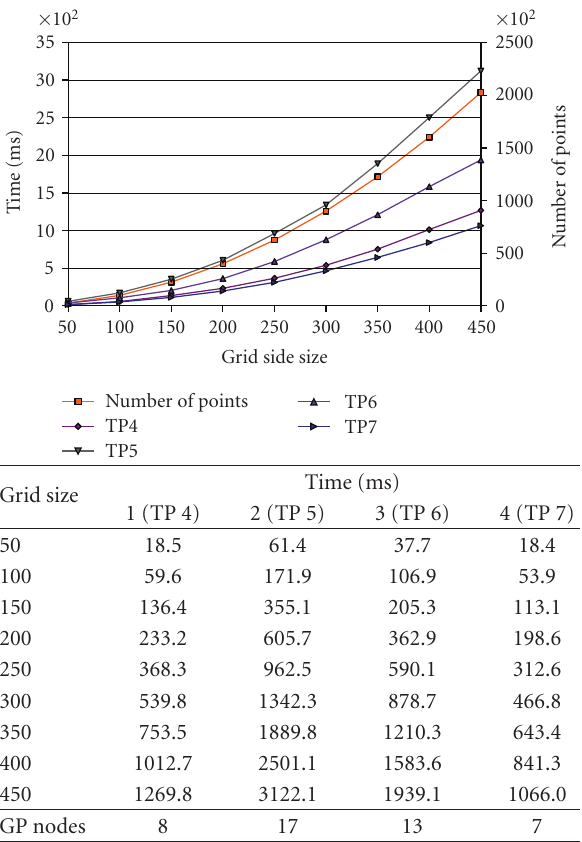
Figure 16: Terrain generation times versus grid